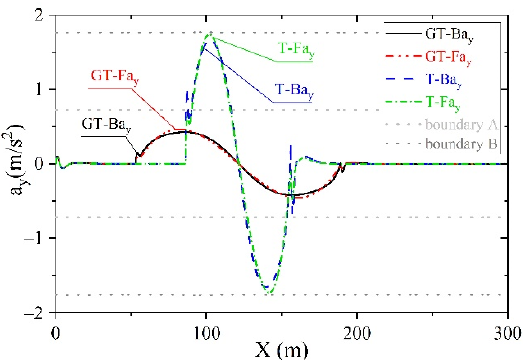
Table 6. Classification of lateral acceleration intensity.